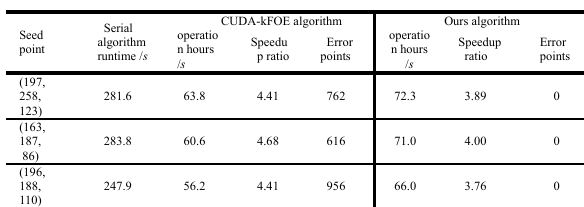
Table 5. CPU vs. GPU refinement